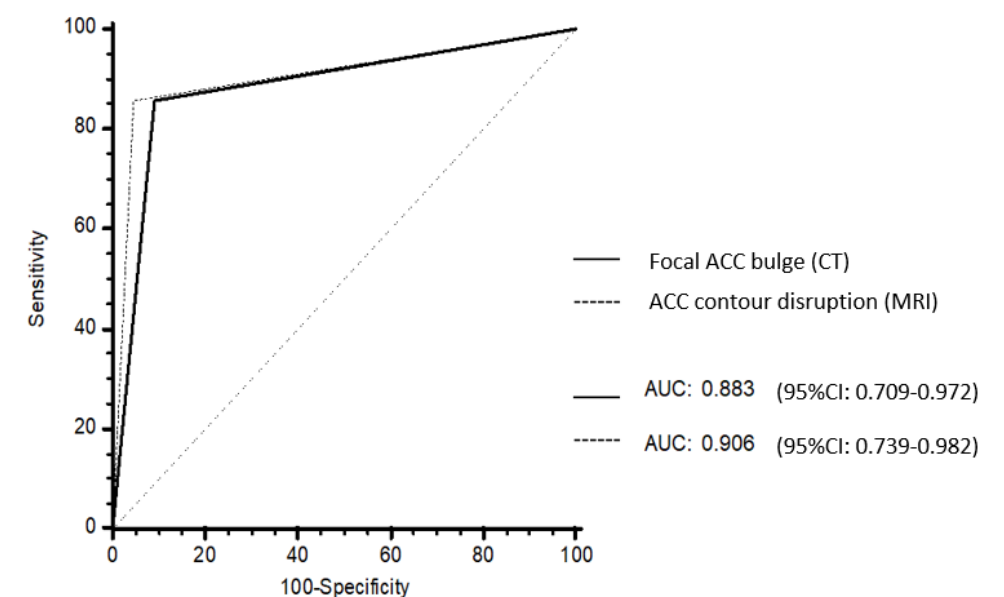
Figure 5. Receiver operating characteristic (ROC) curves of the CT and MRI models. Focal ACC bulge on CT had an area under the ROC curves (AUROC) of 0.883 (95% CI: 0.709–0.972). ACC contour disruption on MRI had an AUROC of 0.906 (95% CI: 0.739–0.982). There was no difference between AUROC at CT and AUROC at MRI ( p = 0.838).